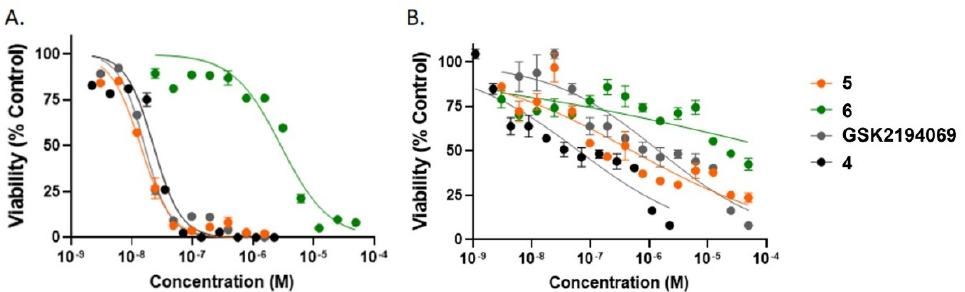
Figure 6. Growth inhibition of ( A ) LNCaP cells or ( B ) PC3 cells following treatment with GSK2194069 (gray), or the non-radioactive standards 4 (black), 5 (orange), and 6 (green) for 4 d. Studies were performed in triplicate.